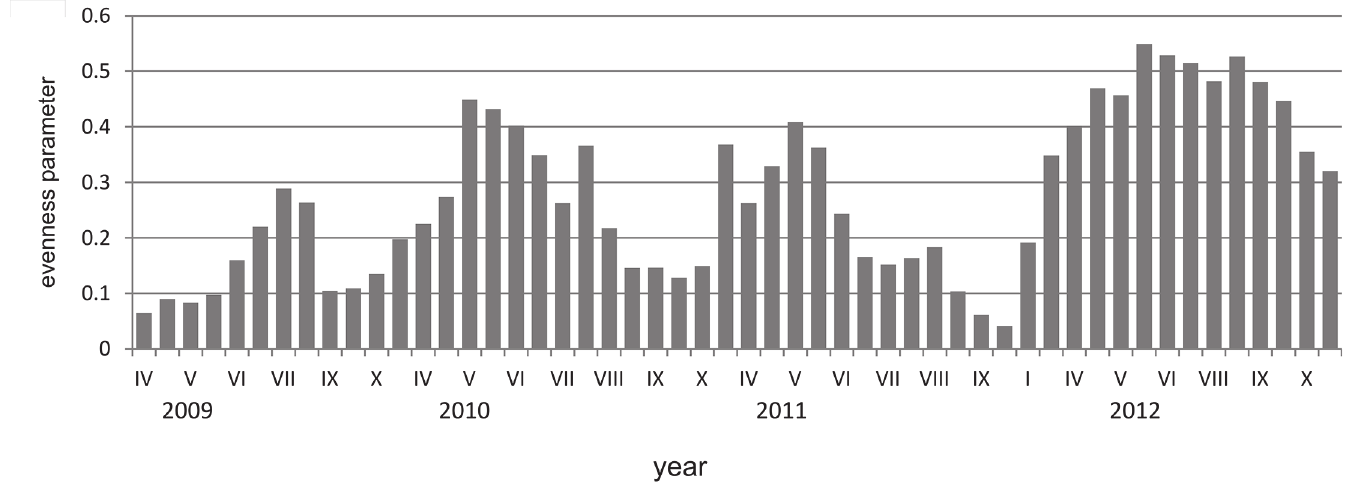
Fig 5. The diversity of evenness parameter in each sampling date in Malta ń ski Reservoir. doi:10.1371/journal.pone.0124738.g005 PLOS ONE | DOI:10.1371/journal.pone.0124738 April 23,